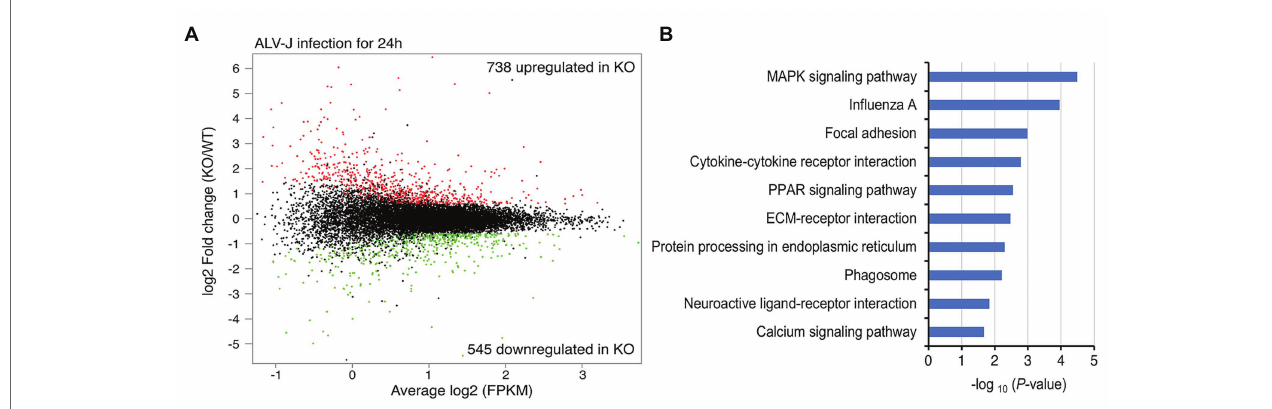
FIGURE 5 | Gene-expression profiling of HD11 cells and DOT1L-KO cells upon ALV-J stimulation. (A) Mean average (MA) plot of genes differentially expressed in DOT1L-KO cells relative to their expression in HD11 cells. The log2 FPKM and log2 fold change between DOT1L-KO cells and WT cells are represented in the x and y axes, respectively. The red and green dots, respectively, indicate the upregulated and downregulated genes, and the black dots indicate no change in expression. FPKM, fragments per kilobase of transcript per million mapped reads. (B) KEGG pathway analysis showing the top 10 enriched